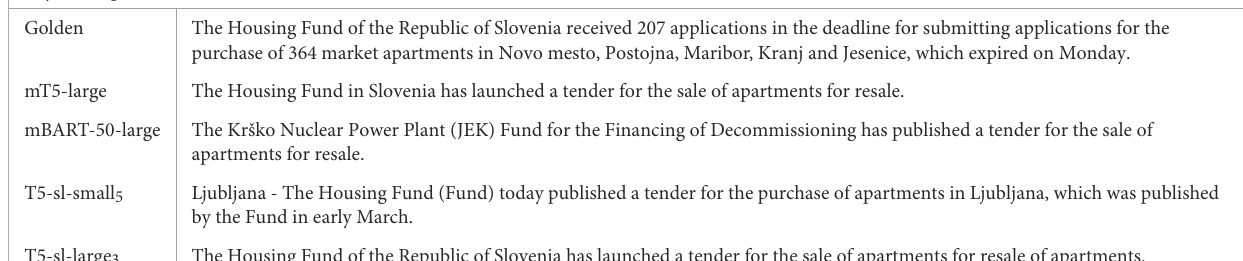
TABLE 9 Translated examples of generated summaries on the ASN summarization task for the best performing models. Candidates will be notified of the selection by 3 April at the latest. As the main request, the Fund received 60 applications for apartments in Novo mesto, 53 for Postojna, 36 for Maribor, 43 for Kranj and 15 applications for apartments in Jesenice. Demand was most pronounced for locations in Postojna and Novo mesto, where the Fund is appearing for the first time and the response was therefore expected. The Fund will examine the received applications in detail, and the selection of buyers will take place on 27 March in the presence of a notary and a commission, in accordance with the provisions The apartments that will remain unsold as part of the selection will be published by the Fund on its website www.ssrs.si on 3 April and sold under the conditions of the tender from 7 April onwards. All interested parties, not only those from specifically listed priority categories, can apply as buyers of apartments for